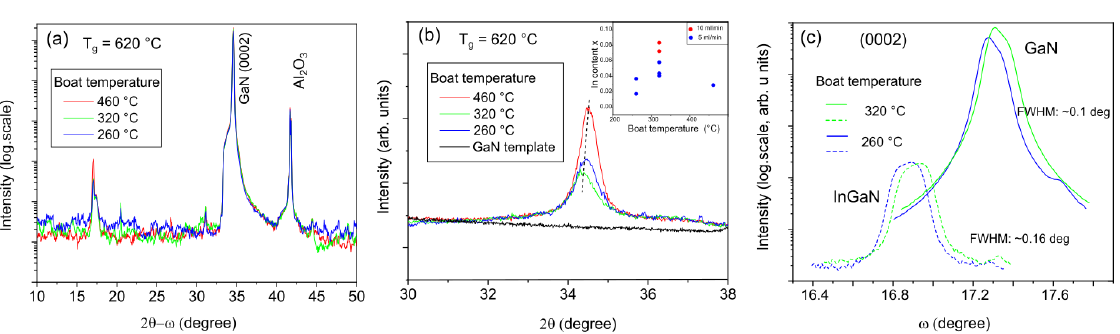
Figure 6. ( a ) XRD patterns measured for the In-doped GaN layers grown at 620 °C on GaN templates using plasma activation of ammonia and different temperatures of the boat with metallic In melt of 460 °C (red line), 320 °C (green line) and 260 °C (blue line). ( b ) Grazing incidence 2 theta scans performed with a small incident angle of 0.5 degrees shown for the same samples as in ( a ) and for the GaN template for reference. The inset shows estimated the indium content vs the boat temperature. ( c ) XRD omega rocking curves for InGaN and GaN (0002) reflections for samples grown with In boat temperatures of 260 °C (blue lines) and 320 °C (green line).